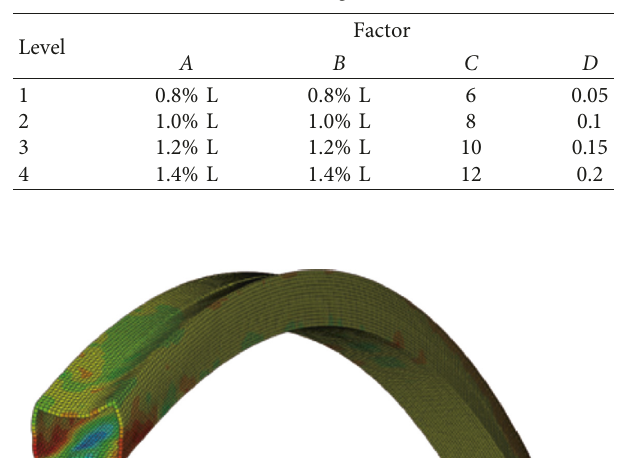
Table 2: Orthogonal test.